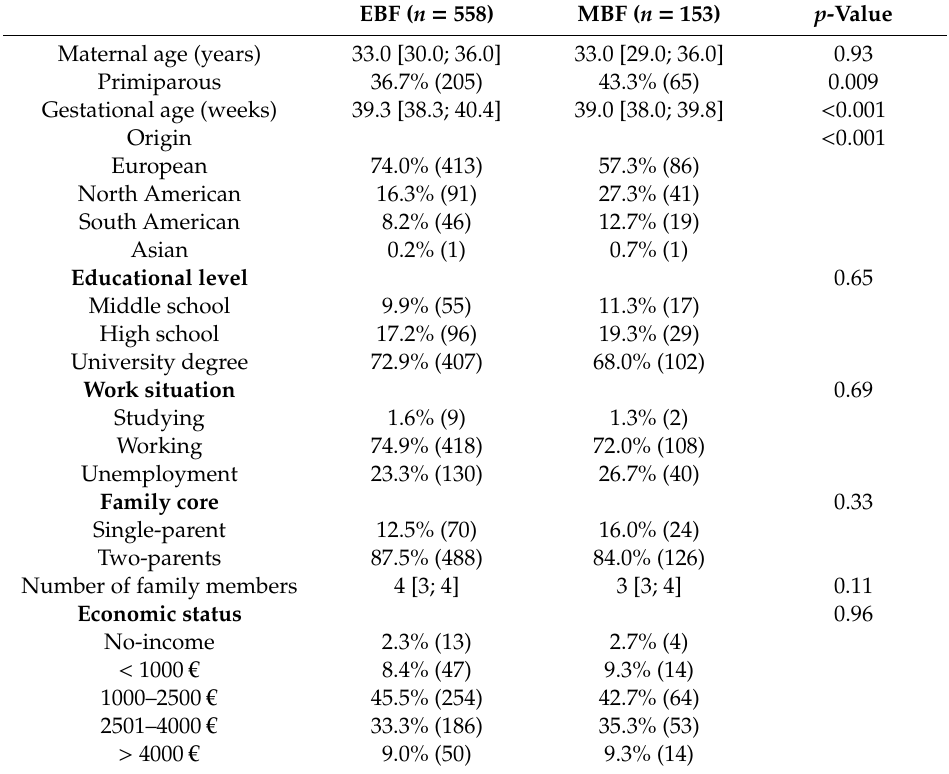
Table 1. Socioeconomic factors according to infant feeding